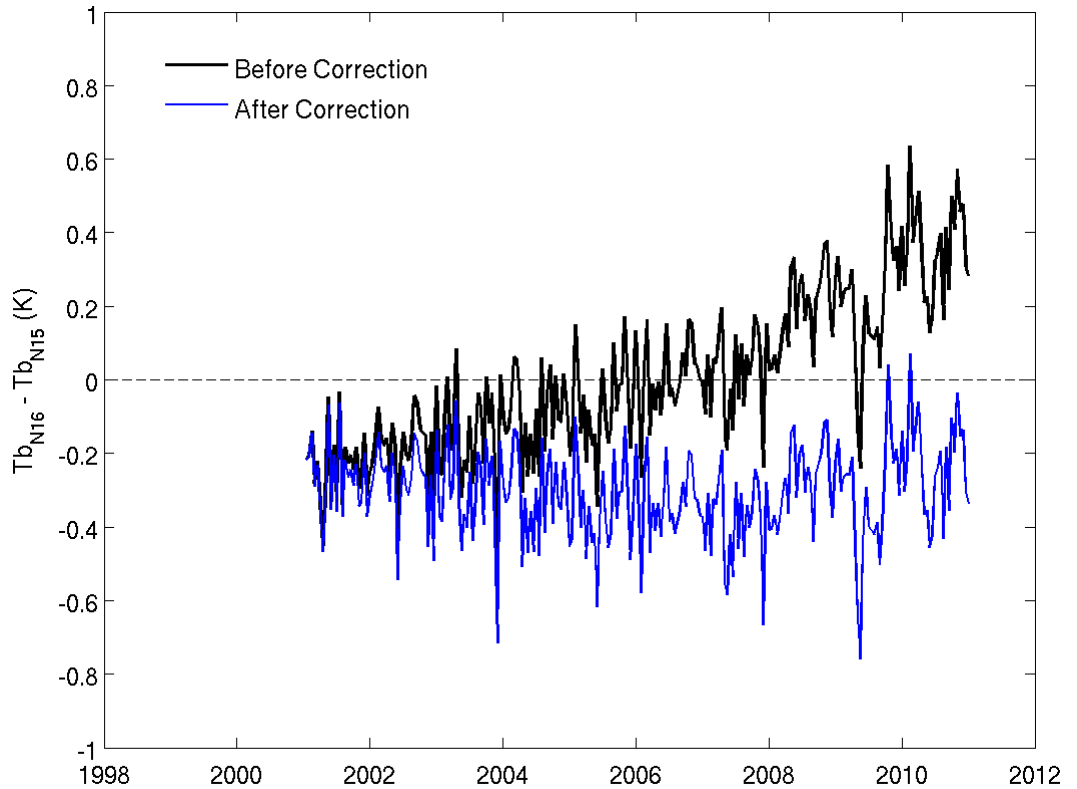
Figure 6. The tropical ocean mean brightness temperature time series of 50.3 GHz channel onboard NOAA-16 versus NOAA-15 displays an upper trend (black curve), a new time series (blue curve) is formed through removing the trend line.